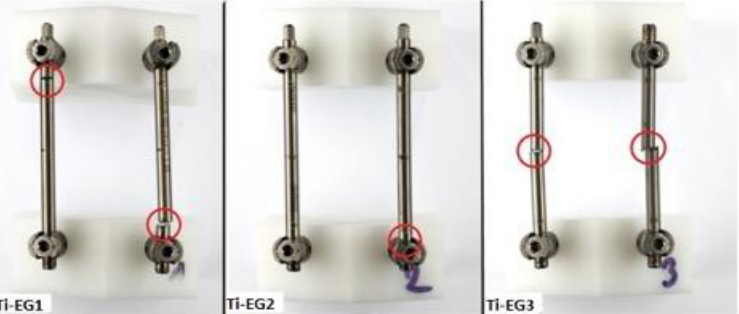
Figure 4. Sites of rod fracture of titanium electrocautery group (Ti-EG) post biomechanical testing. Ti-EG revealed a significantly lower load-to-failure than Ti-CG (17% decrease, p = 0.023). Intergroup comparison of cycles to failure revealed a significant mean decrease of almost 9 × 10 5 cycles ( p = 0.03). (Figure 5).